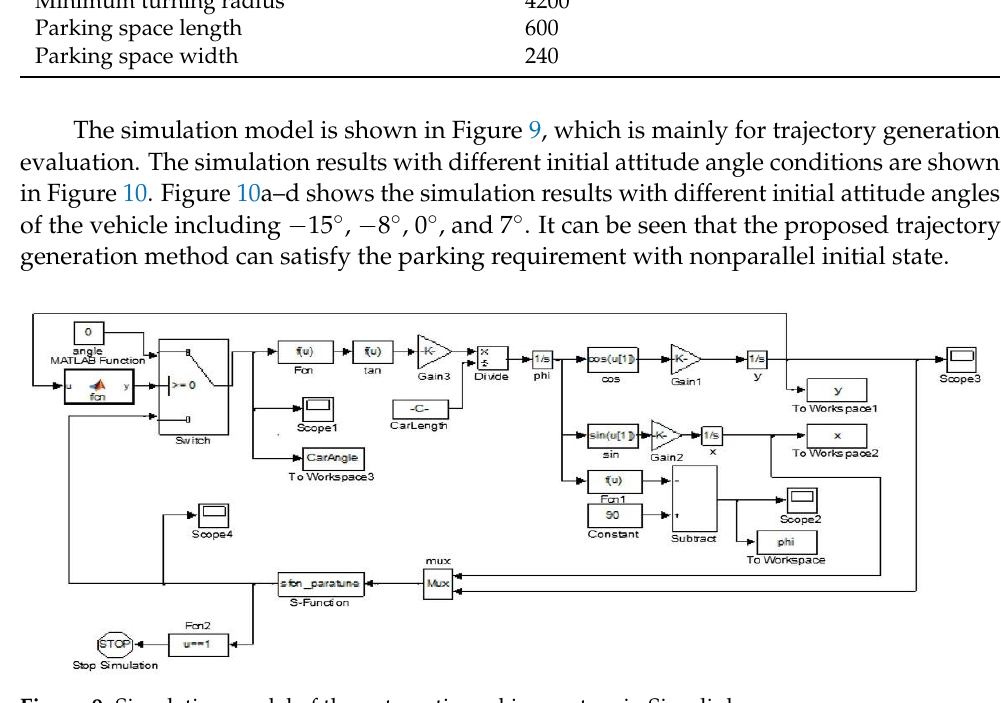
Figure 10. Parking simulation results under nonparallel initial state condition. ( a – e ) respectively are the simulation results of different initial conditions 4.2. Real Vehicle Experiment In Equation (5),  4.6m 1.8m vehicle. The role of the stake not only simulates the parking spot, but also represents other vehicles existing, which means if the target vehi- cle strikes the stake, the experiment is a failure. Figure 11. Virtual parallel parking environment.